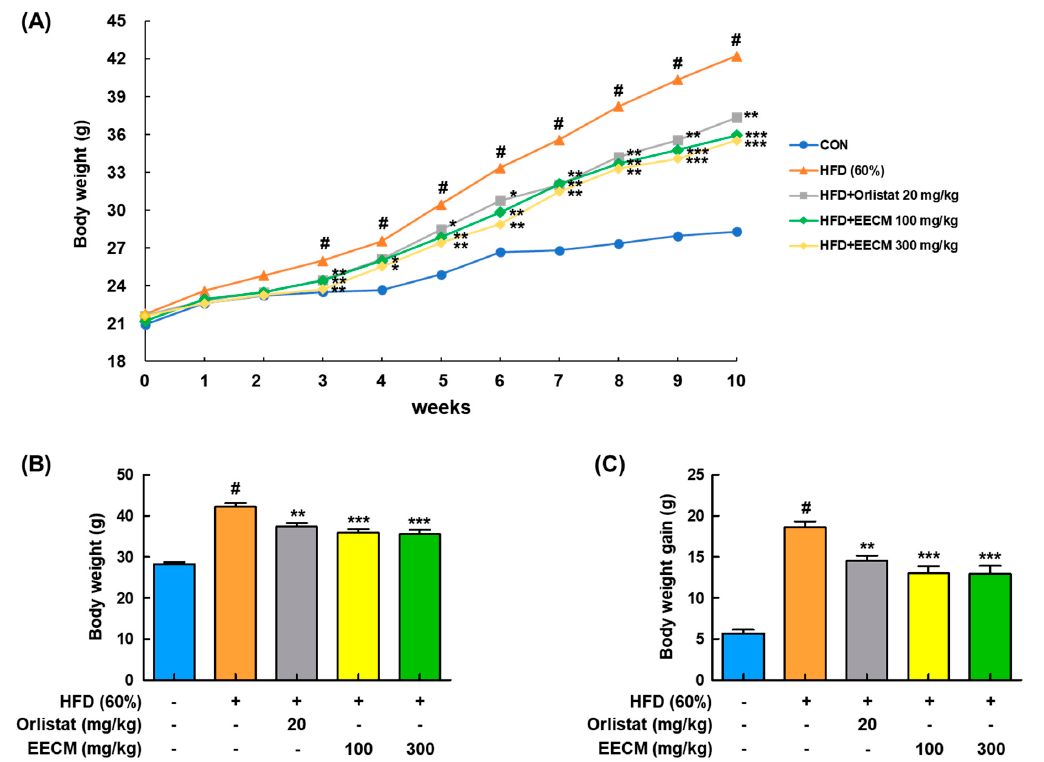
Figure 4. Repressive effect of EECM on body weight gain in HFD (60%)-induced obese mice. Mice of EECM treatment were provided the indicated dose of EECM (100 and 300 mg/kg) daily during the experiment. ( A ) Body weight changes, ( B ) total body weight at the endpoint of the experiment, and ( C ) total body weight gain for 10 weeks. Values are represented as the mean ± SEM of eight mice per group. # p < 0.05 vs. the control (CON) group; * p < 0.05, ** p < 0.01, and *** p < 0.001 vs. the HFD (60%)-induced obese group.